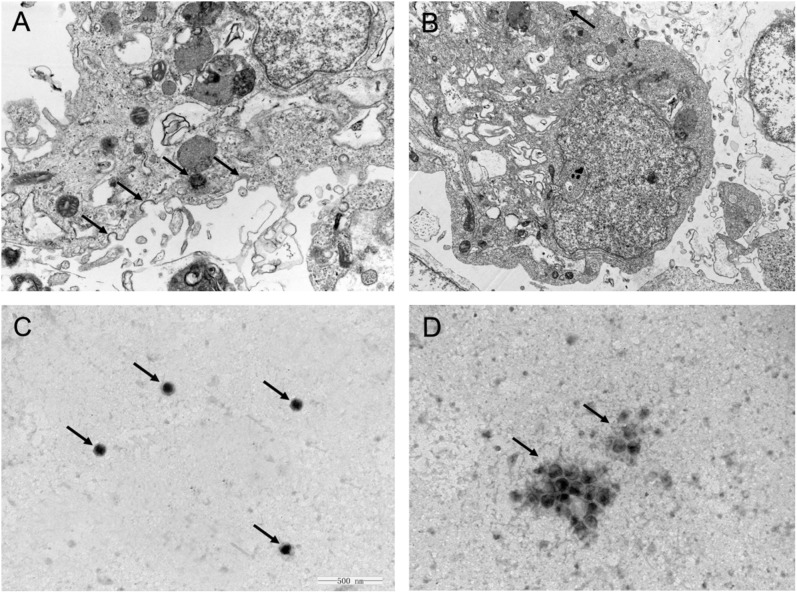
Aloe polysaccharides interferes with viral adsorption to MDCK cells. MDCK monolayers were infected with MOI = 1 of PR8 virus in the absence (A) or presence (B) of APS treatment (40 μg/mL). At 4 h post-infection, the cells were centrifuged and fixed to prepare ultrathin sections, and the virions in cells were imaged via TEM (30000×). The virions on the cell membrane surface and in the endosomes were denoted by black arrowheads. Te purified PR8 virus (C) and the mixture of virus and APS (D) were imaged via TEM after negative staining (60000×). The virions were denoted by black arrowheads.